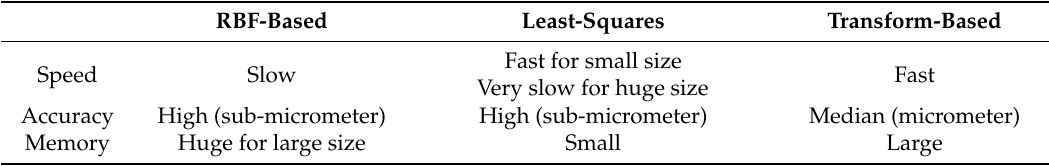
Table 2. Comparison of three integration